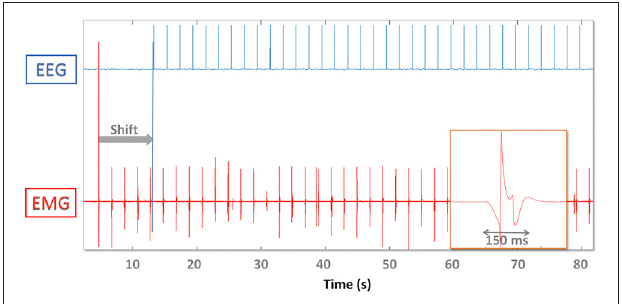
FIGURE 3 | Digital EEG (top) and analog EMG (bottom) synchronization spikes. EMG data are shifted (gray arrow “Shift”) and time warped so that the first and last spike coincide. On the lower right one analog EMG spike is magnified and demonstrates the effect of the hardware analog filter. The EMG spike amplitude and shape varies throughout the